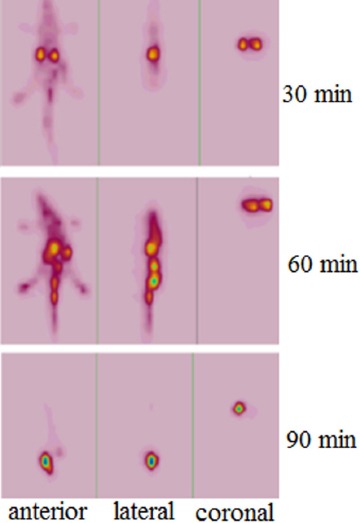
Static images of 68Ga-DOTA-ALN in normal rats at 30, 60, and 120 min after the injection (4.4 MBq for each rat)